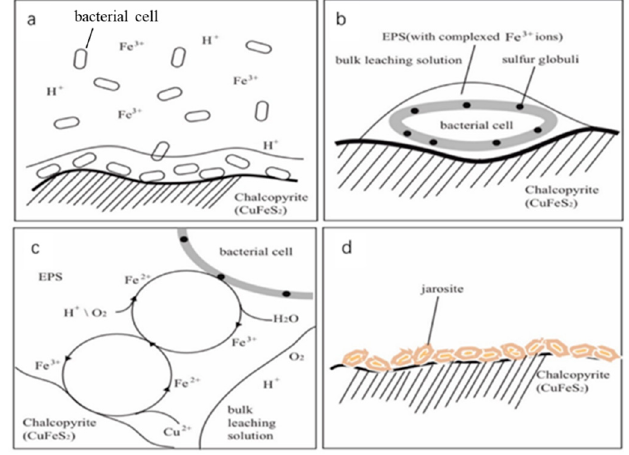
Figure 10. Schematic diagram of chalcopyrite bioleaching and jarosite formation. ( a ) Adsorption bacteria on chalcopyrite surface, ( b ) Microenvironment between bacteria, EPS and minerals, ( c ) Fe 2 + was oxidized to Fe 3 + on the cell wall of bacteria, and consuming H +, ( d ) Jarosite crystal precipitation.